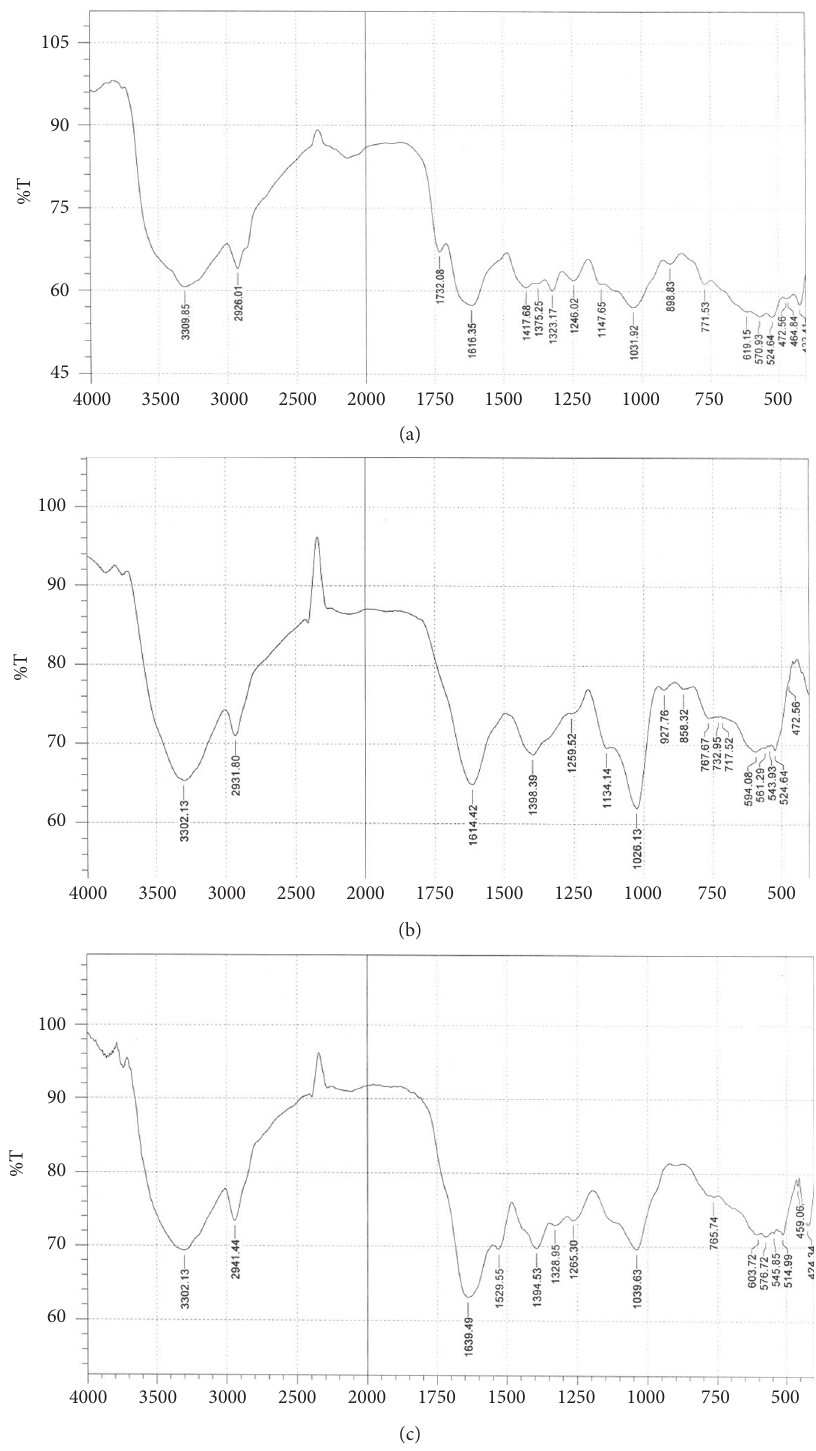
Figure 2: FTIR characterization of hydrocolloid extracted from S. surattense (a), S. nigrum (b), and S. indicum